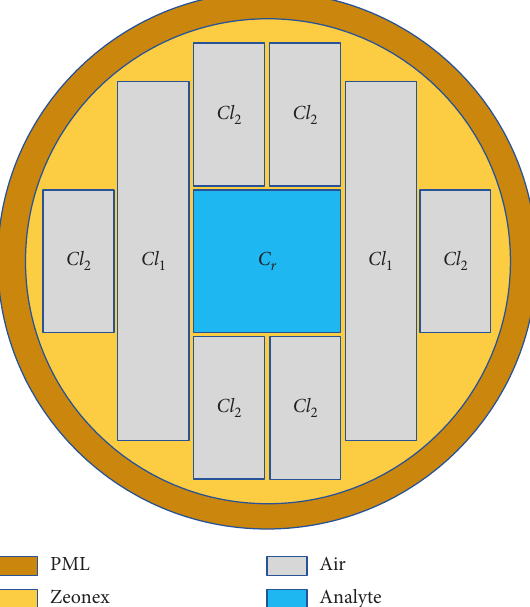
Figure 1: The x - y plane representation of the proposed R-PCF-based BCS.